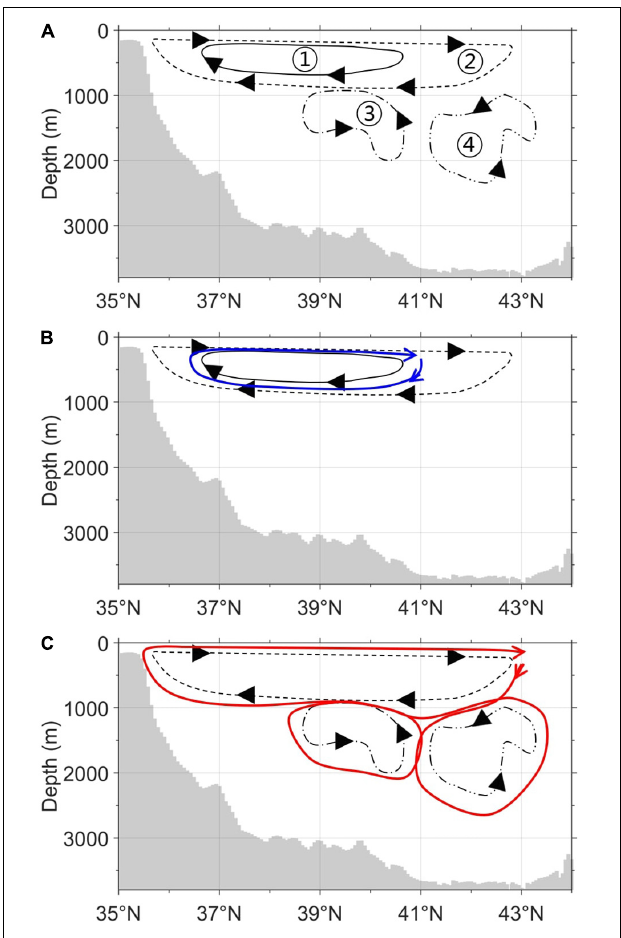
FIGURE 3 | (A) Streamlines of 0.3 Sv ( (cid:192) : solid line), 0.1 Sv ( (cid:193) : dashed line), and − 0.1 Sv ( (cid:194) : left dot-dashed line and (cid:195) : right dot-dot-dashed line) for the mean convection case in the meridional overturning stream function from Figure 2A . Individual turnover times are (cid:192) 17.91, (cid:193) 18.04, (cid:194) 16.95, and (cid:195) 23.6 years, respectively. (B) Turnover times of upper cells from ∼ 300 to ∼ 700 m and from ∼ 300 to ∼ 900 m: (cid:192) 17.91 and (cid:193) 18.04 years, respectively. (C) Turnover times of upper and lower cells: ( (cid:193) + (cid:194) ) 34.99 years, ( (cid:193) + (cid:195) ) 41.64 years, and ( (cid:193) + (cid:194) + (cid:195) ) 58.59 years, respectively.